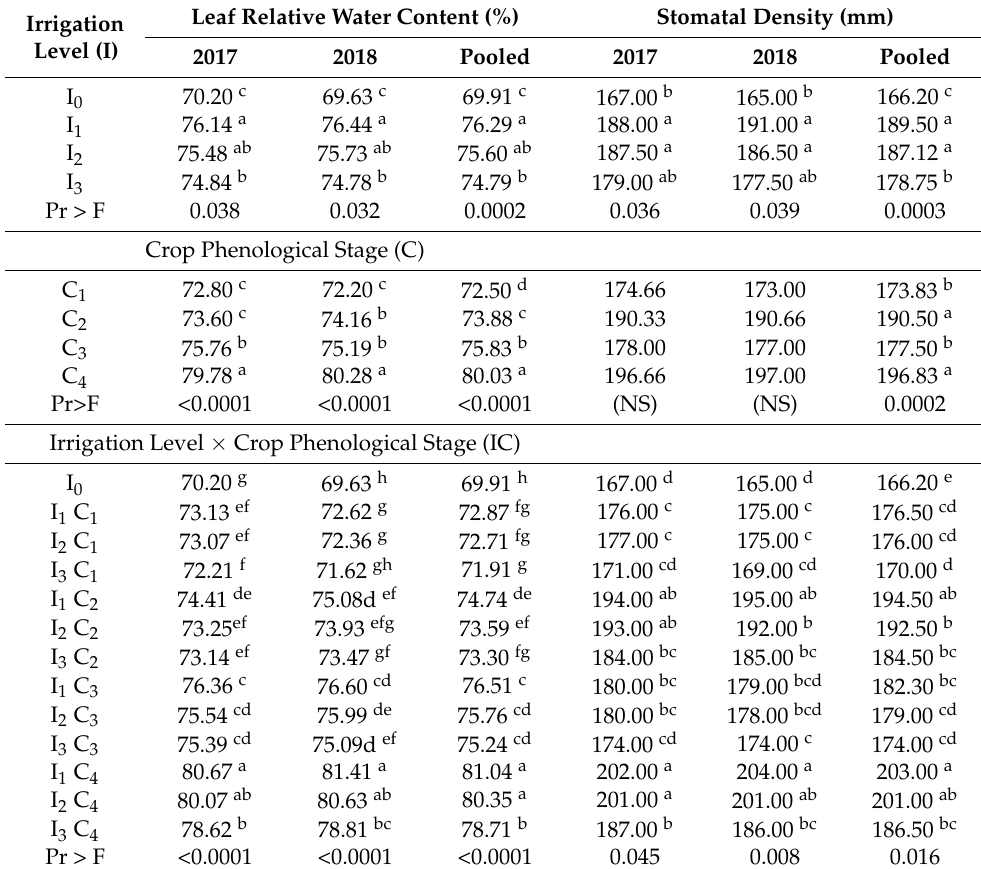
Table 6. Effect of different irrigation levels at various crop phenological stages on leaf relative water content and stomatal density of apple (cv. Super Chief